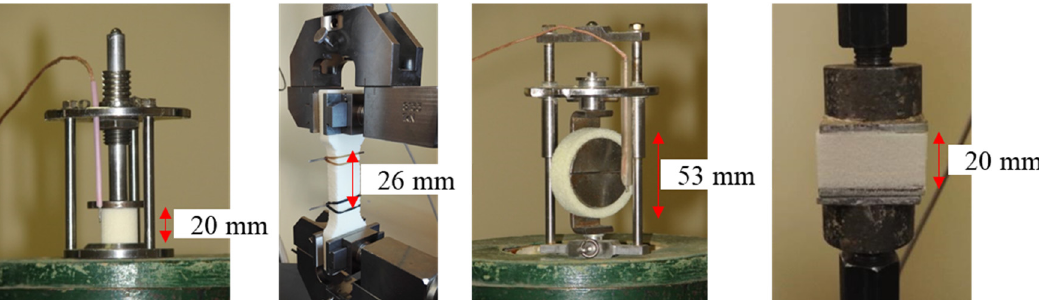
Figure 1. Sample of rigid PUR foam for compression tests and tensile tests at 293 K, tensile tests at 77 K and with aluminium plates prepared for adhesion test.